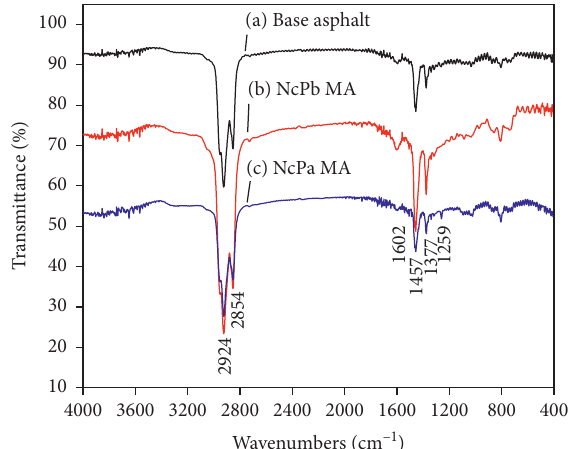
Figure 15: FTIR spectra of the base asphalt and nanocarbon- modified asphalt.